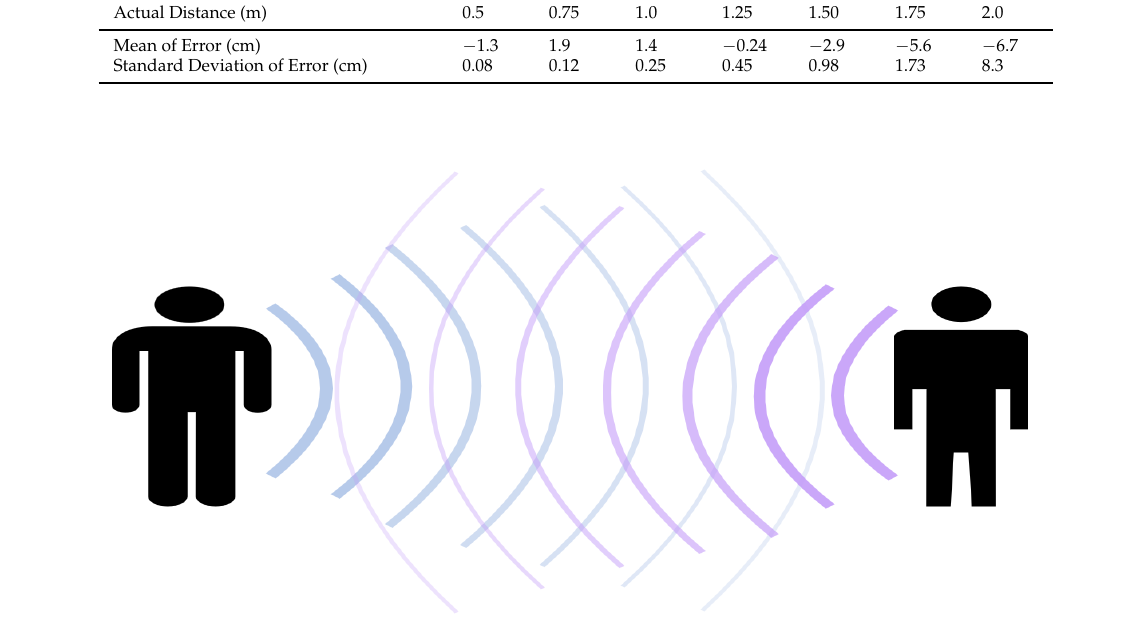
Figure 9. People in the range of the magnetic field while wearing the prototype on